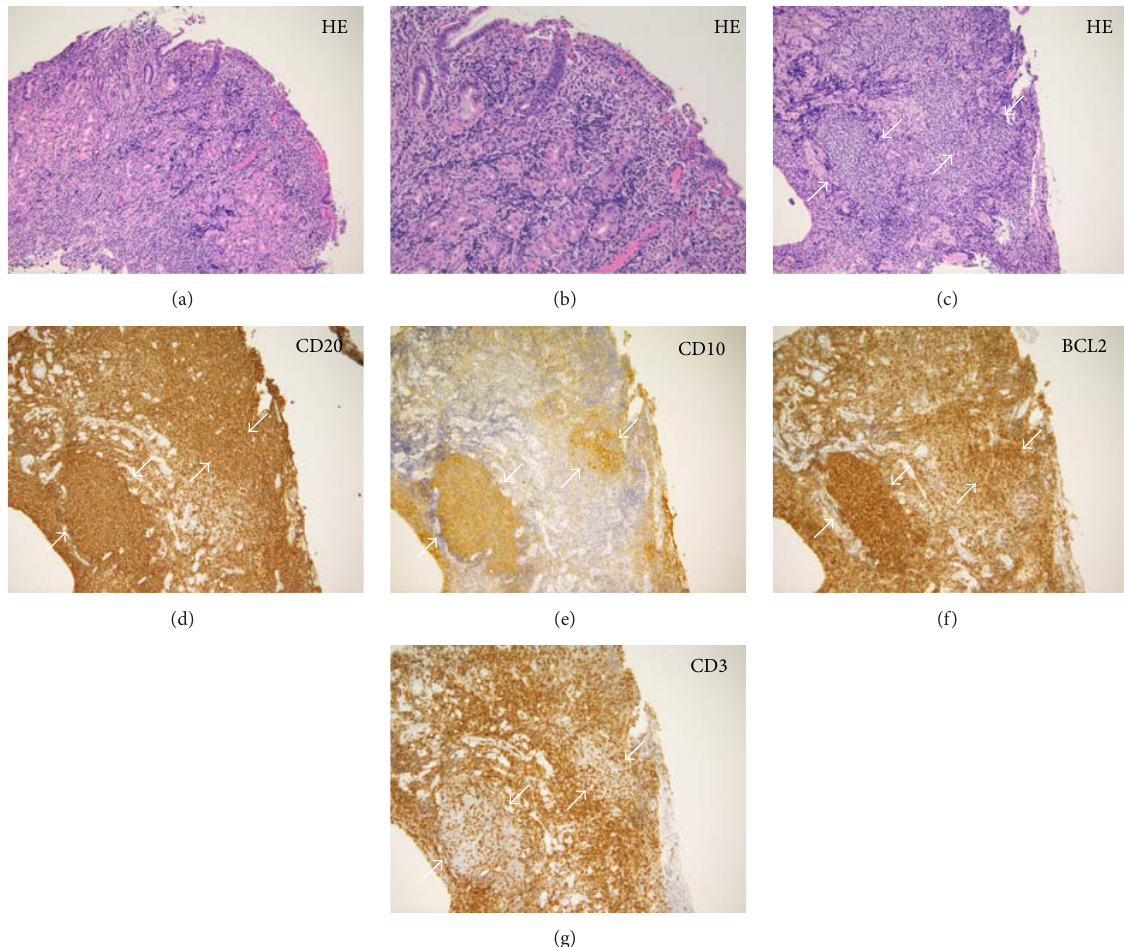
Figure 4: Histological images of stomach tissue biopsies from case 2. Dense, diffuse infiltration of small- to medium-sized lymphoma cells was observed, in addition to the existence of granulation tissues, with preserved epithelial cells, from biopsy samples taken from the gastric mucosa where intact pits were observed (hematoxylin and eosin staining, (a) × 20, (b) × 40). An image from biopsy samples taken from where damaged gastric pits were observed shows lymphoma infiltration, but with loss of epithelial cells ((c), hematoxylin and eosin staining, × 20). Neoplastic lymphoid follicles are shown (arrows). Lymphoma cells were positive for CD20 ((d), × 20), CD10 ((e), × 20), and BCL2 ((f), × 20) and negative for CD3 ((g), × 20).